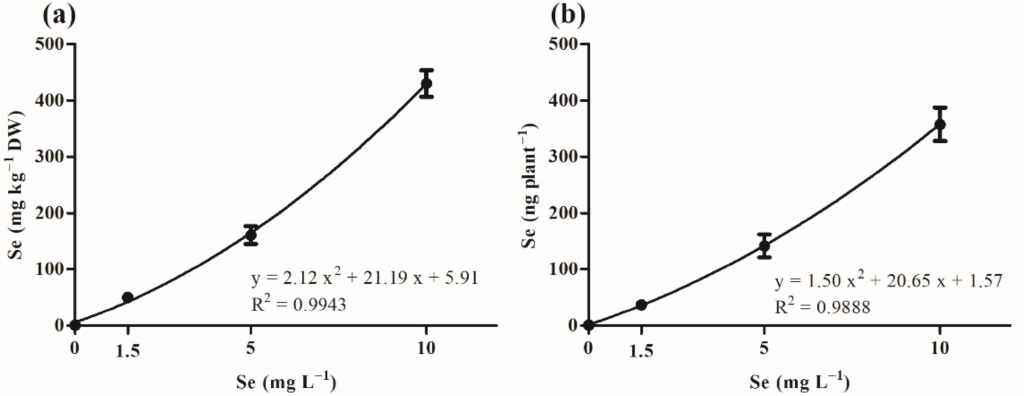
Figure 2. Nonlinear regression of Se concentration (mg kg − 1 DW) ( a ) and content (ng plant) ( b ) of biofortified microgreens of P. oleracea and Se concentration in the substrate.